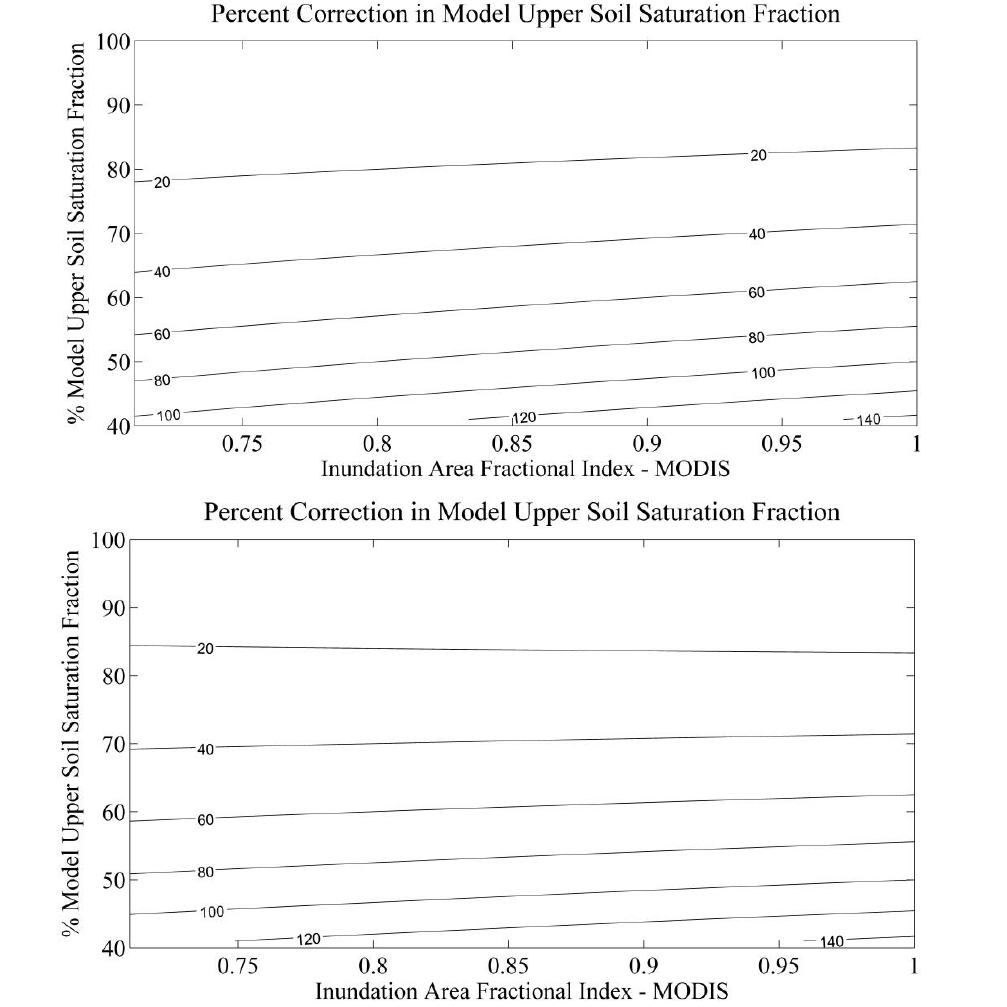
Figure 2. Mean B F as function of f (fraction) and w (in %) for Mean( v ) = 0 (upper panel) and Mean( v ) = 0.2 (lower